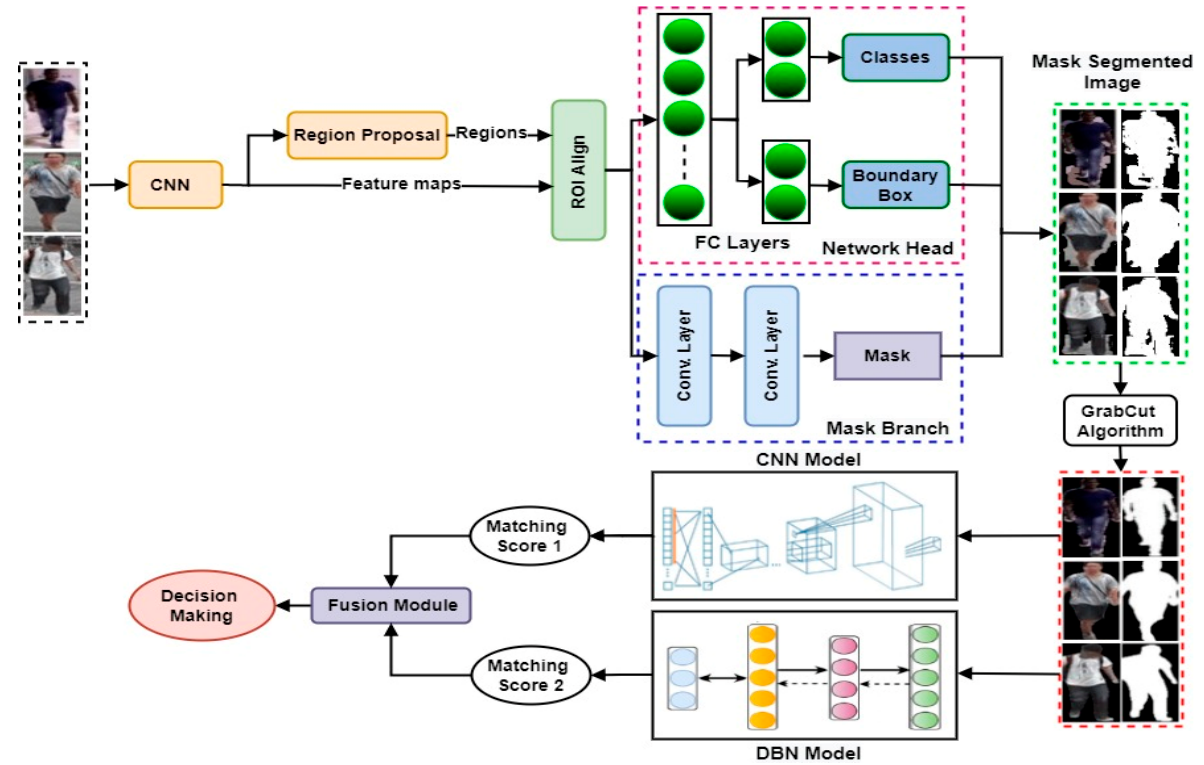
Figure 1. The overall structure of the proposed ReID-DeePNet system.